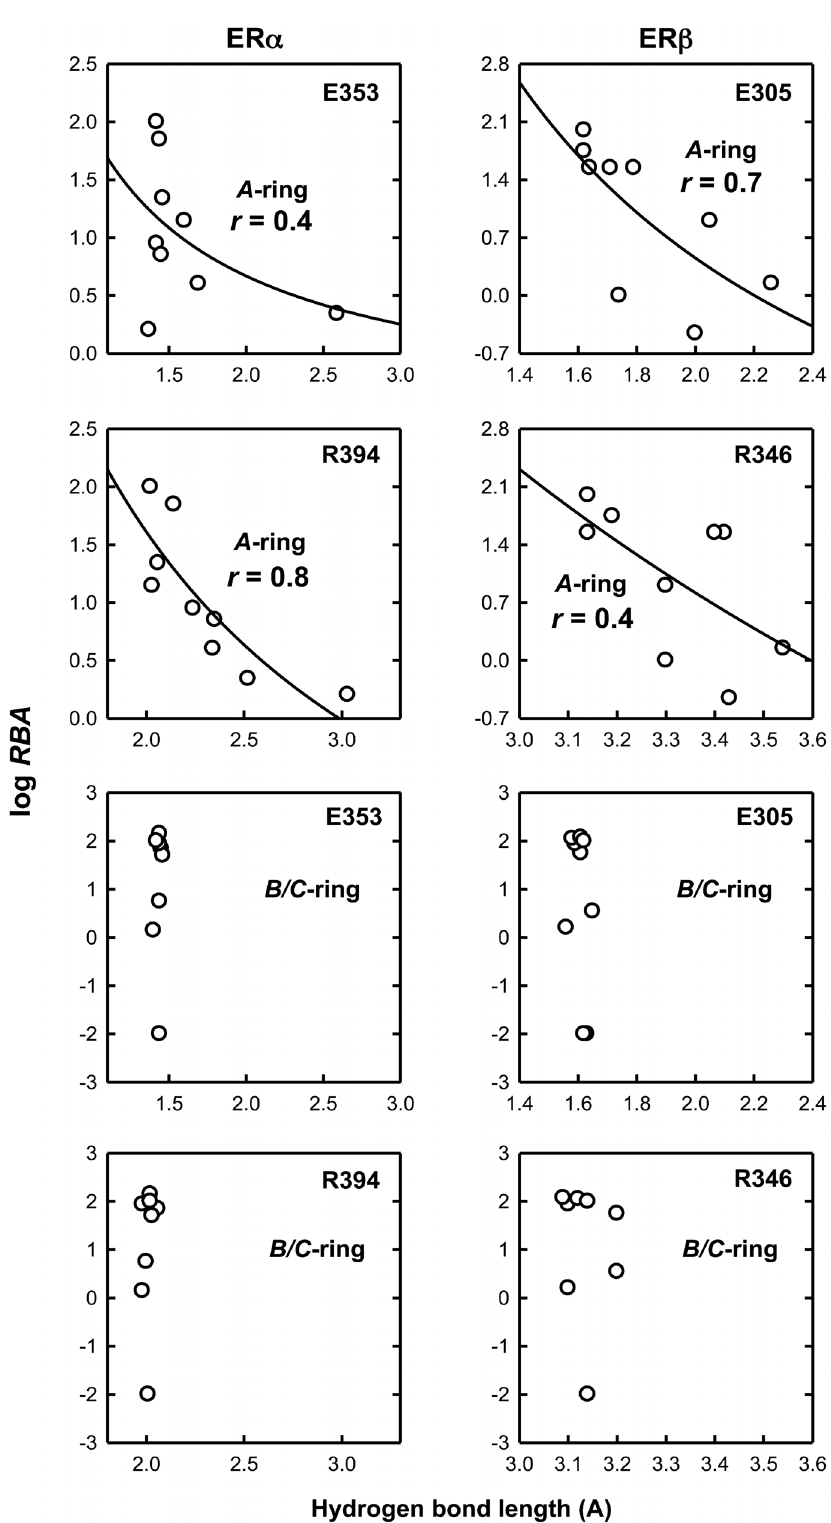
Figure 5. Correlation of hydrogen bond length and log RBA of A -ring and B / C -ring derivatives. The hydrogen bond length data were shown in Table 1 . The amino acids shown in the up right corner of each indicated that the hydrogen bonds were formed between 3-hydroxyl groups of the A -ring or B / C -ring derivatives and this specific amino acid in the binding pocket. The curve regression was performed according to the Inverse First Order equation y=y 0 + a/x.